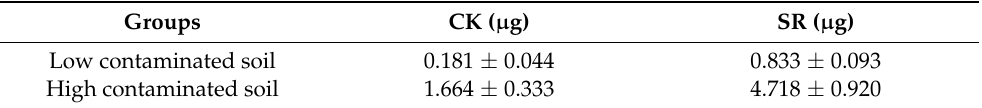
Table 2. The total uptake of Cd content in